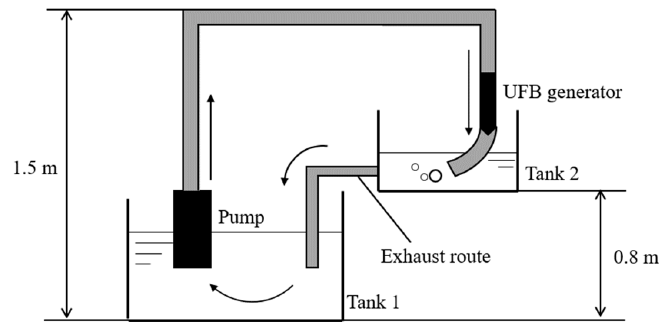
Figure 1. Schematic of the ultrafine bubble (UFB) generation system. Table 1. Specifications of the system.